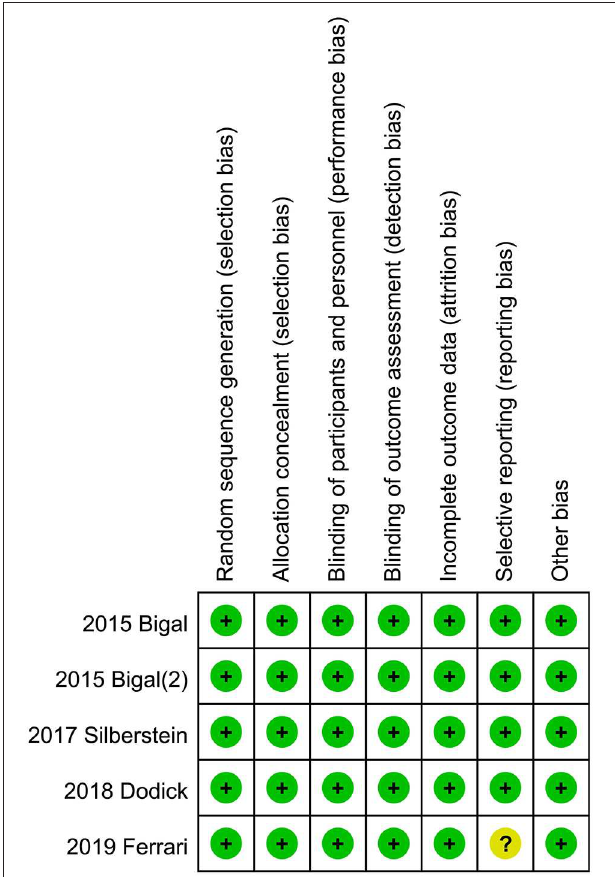
FIGURE 4 | Risk of bias: a summary table for each risk of bias item for each study.